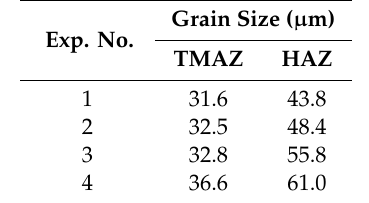
Table 9. Grain size of thermo-mechanically a ff ected zone (TMAZ) and heat a ff ected zone (HAZ) for Experiments